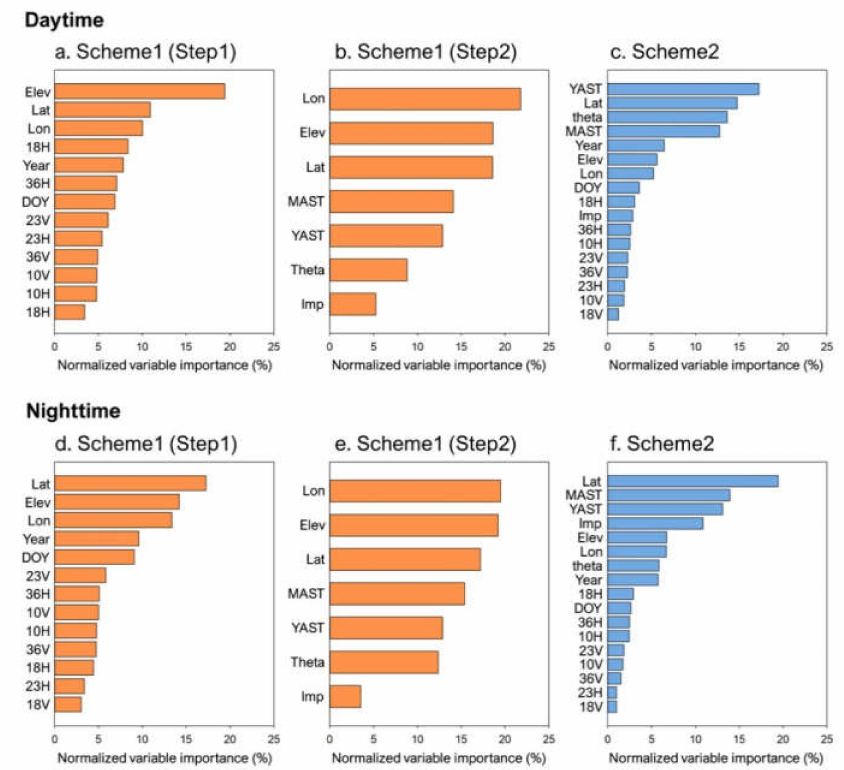
Figure A1. Normalized relative variable importance calculated from the RF models of two steps (step 1 and step 2) for scheme 1 (S1), the orange bar; and scheme 2(S2), the blue bar, for daytime ( a – c ) and nighttime ( d – f